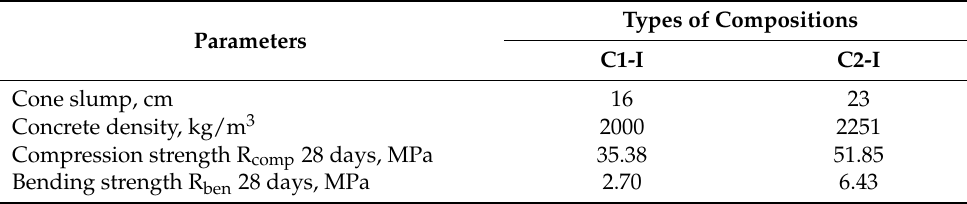
Table 6. Test results of the compositions at the first stage.